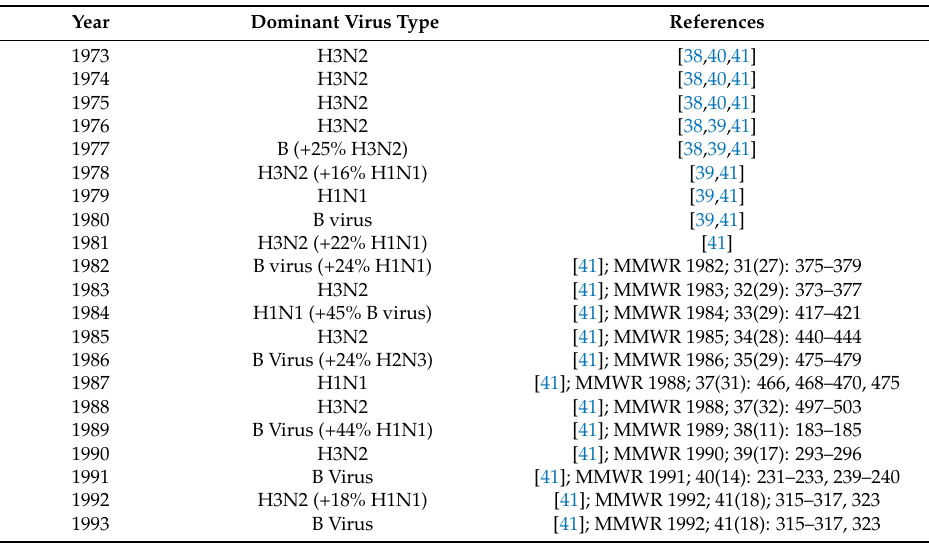
Table 6. The dominant circulating virus type for each northern hemisphere season ending in the years 1973–1993 is shown with references. An additional virus is listed if it contributed to more than 15% of the positive isolates for that season (data from